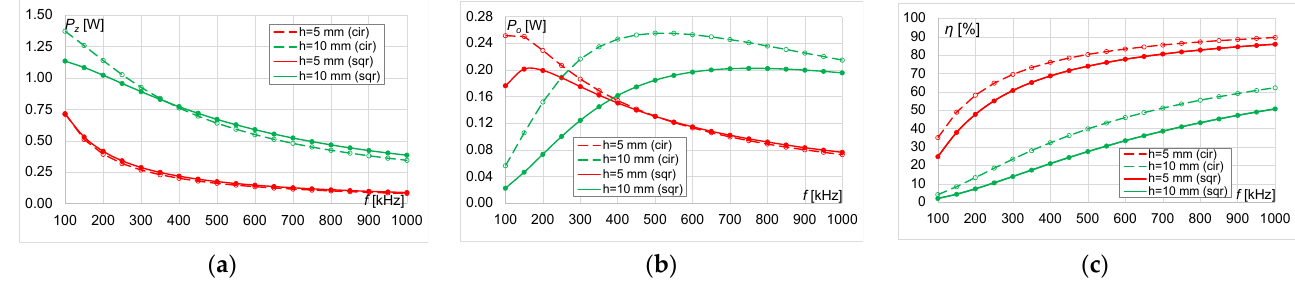
Figure 9. Results for circular and square coils with r = 10 mm and number of turns n = 25 at different distances ( h = 5 mm and h = 10 mm): ( a ) transmitter power, ( b ) receiver power and ( c ) power transfer efficiency.